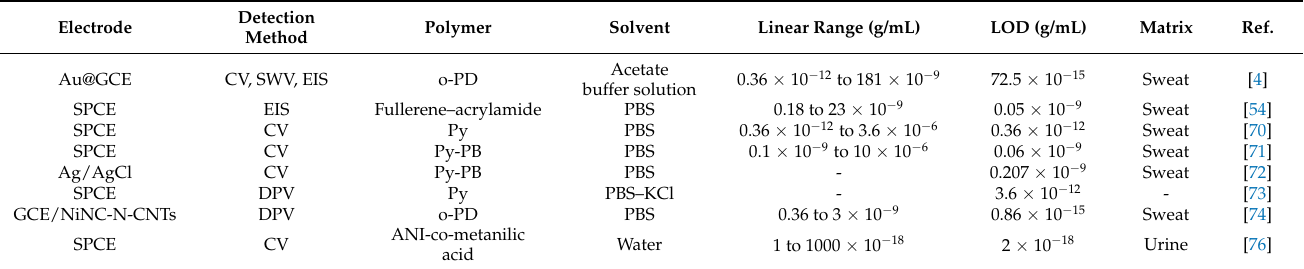
Table 4. Summary of MIP formation via surface